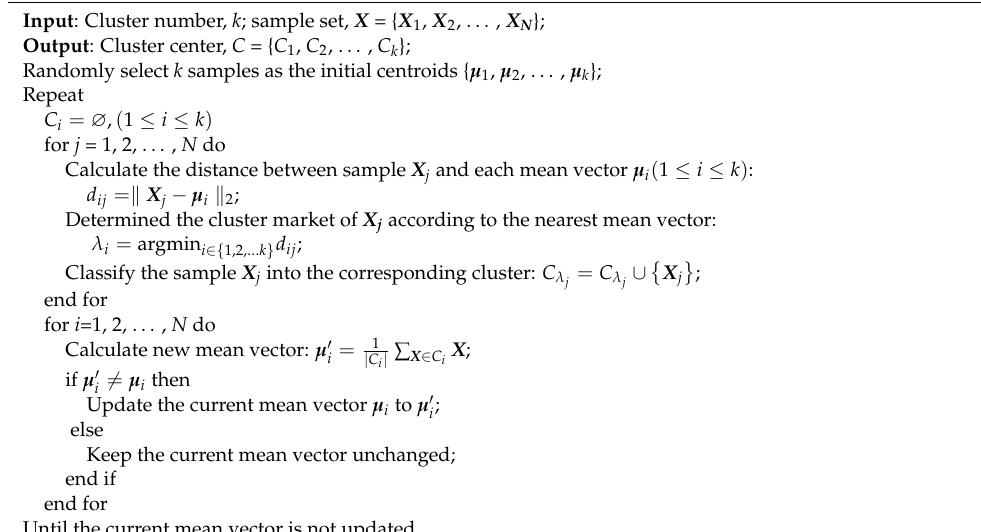
Algorithm 1: Coordinate Clustering based on